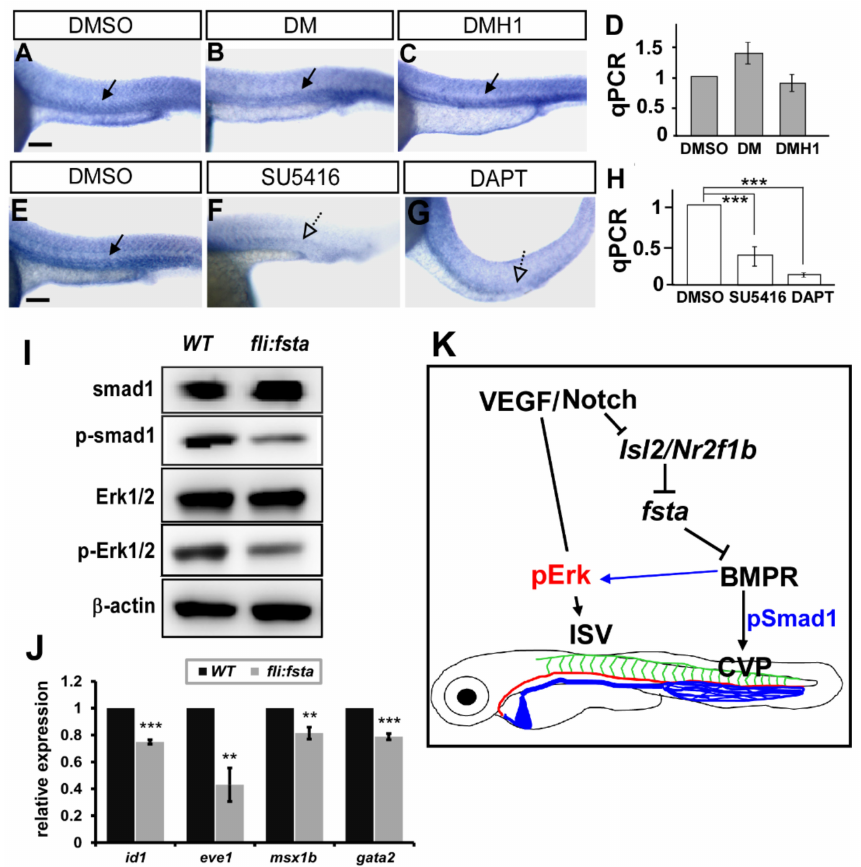
Figure 7. Fsta regulates BMP signals to control vascular patterning. ( A – D ) Inhibition of VEGF or Notch signals by SU5416 or DAPT treatment reduced the expression of fsta compared to DMSO- treated control. ( E – H ) Inhibition of BMP signals by DM or DMH1 treatment did not reduce the expression of fsta in embryos by in-situ hybridization and qPCR analysis. ( I ) Representative western blot assays showed the reduced phosphorylation of smad1 and ERK1/2 in (fli:fsta ) embryos. β -actin serves as loading controls. ( J ) The decreased expression of BMP regulated genes id1 , eve1 , msx1b and gata2 . qPCR data are presented as the mean ± S.D. *** refers to p < 0.0001 and ** refers to p < 0.001 by an unpaired Student’s t -test. Scale bar represents 200 µ m in ( A – C , E – G ). ( K ) Schematic drawing shows the genetic regulation of fsta , isl2/nr2f1b , and multiply signals. Our data suggest that fsta functions in ISV growth and CVP patterning mediated by BMP signal